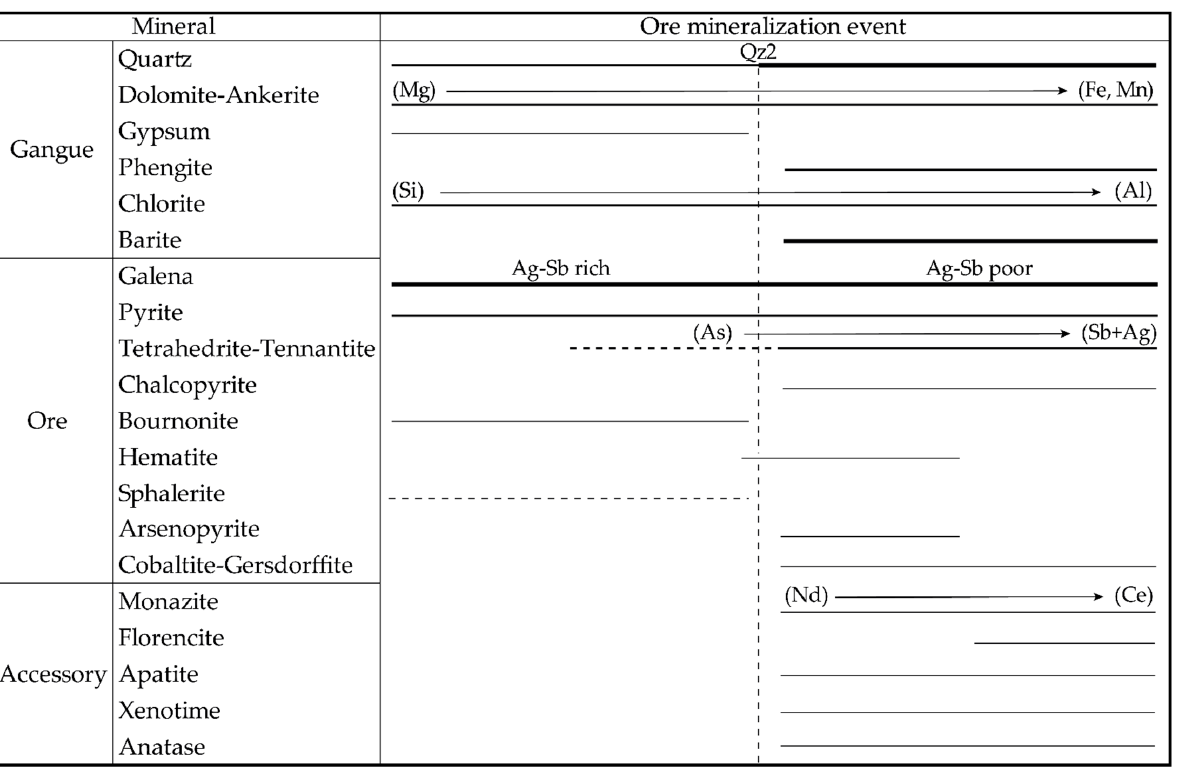
Figure 6. A common paragenesis for the Macôt-la Plagne and the Peisey-Nancroix Pb-Ag deposits. The thickness of the line represents the proportion of each phase. The thickness of the line represents the proportion of each